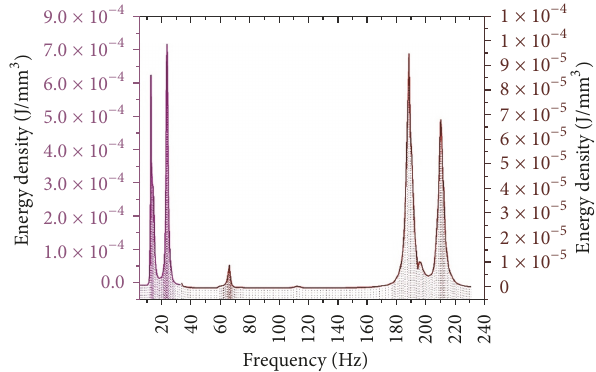
Figure 15: Energy density versus frequency